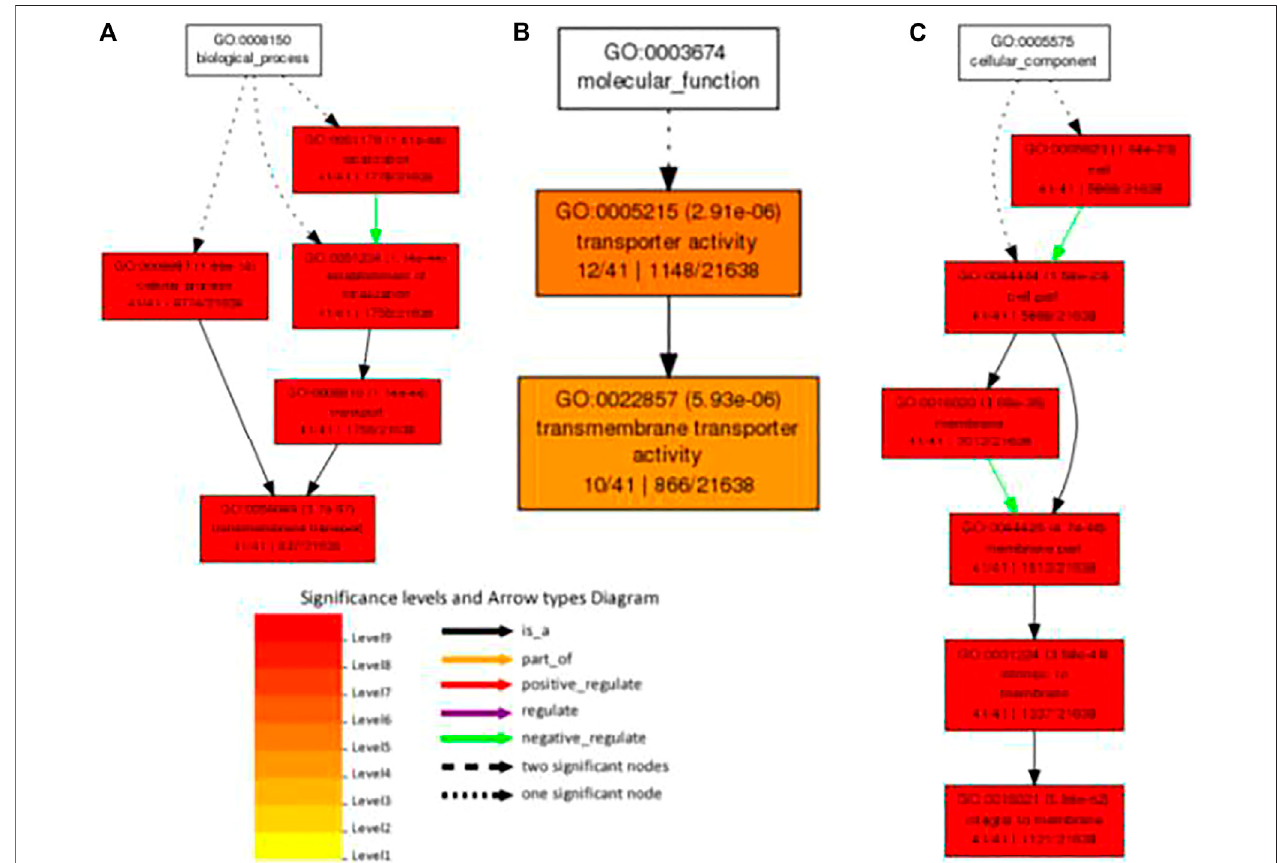
FIGURE14| GOanalysisof PdpapMFS genesindifferentclassi fi cations. (A) GOanalysisofbasedonbiologicalprocesses. (B) GOanalysisofbasedonmolecular functions. (C) GO analysis of based on cellular